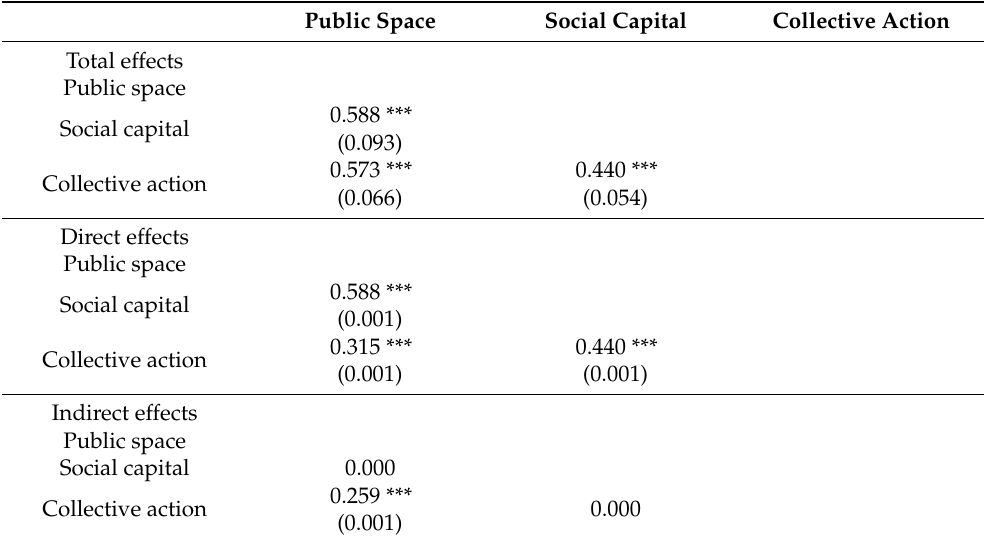
Table 5. Total, direct and indirect effects of public space based on